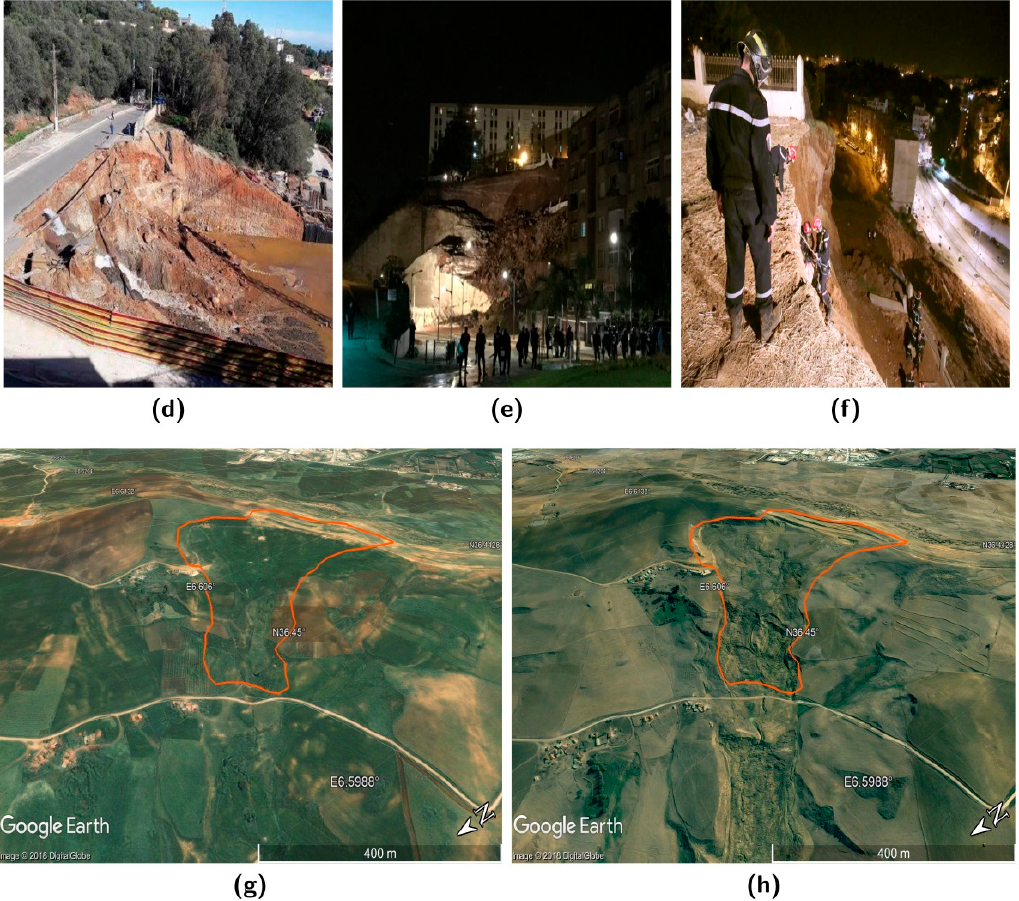
Figure 3. Landslide examples (Source: Mila and Constantine municipalities, Location: see Figure 1): ( a ) RN 79a, (Type: Deep-Rotational landslide; Date: October 2011); ( b ) Sibari (Type: Shallow-Planar landslide; Date: February 2008); ( c ) Mila (Type: Deep-Rotational landslide; Date: September 2013); ( d ) Grarem (Type: Planar landslide; Date: June 2015); ( e,f ) Mila (Type: Deep-Rotational landslide; Date: October 2017); ( g , h ) Didouche Mourad (Type: Deep-Rotational landslide; Date Left: August 2003, Date Right: September 2005).